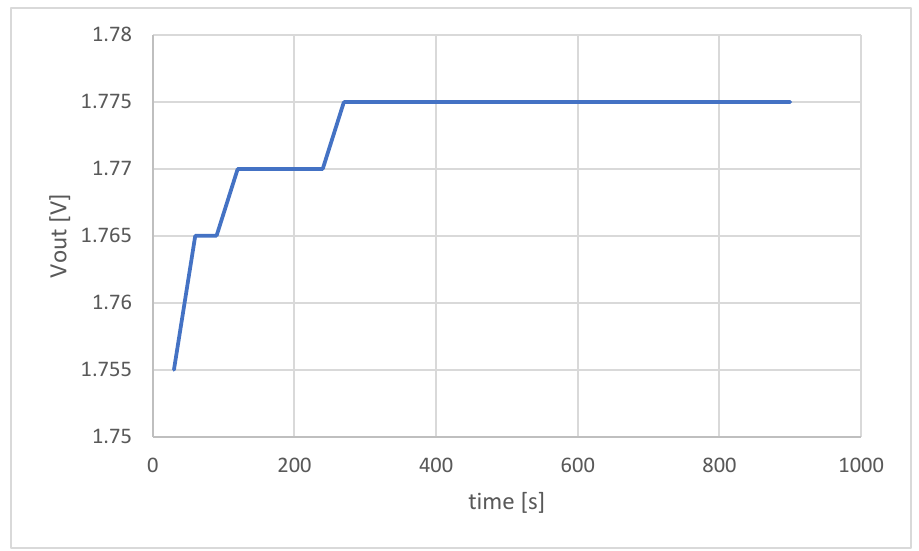
Figure 9. Dynamic response of the ISE probe for the nitrate standard concentration of 200 mg/L.